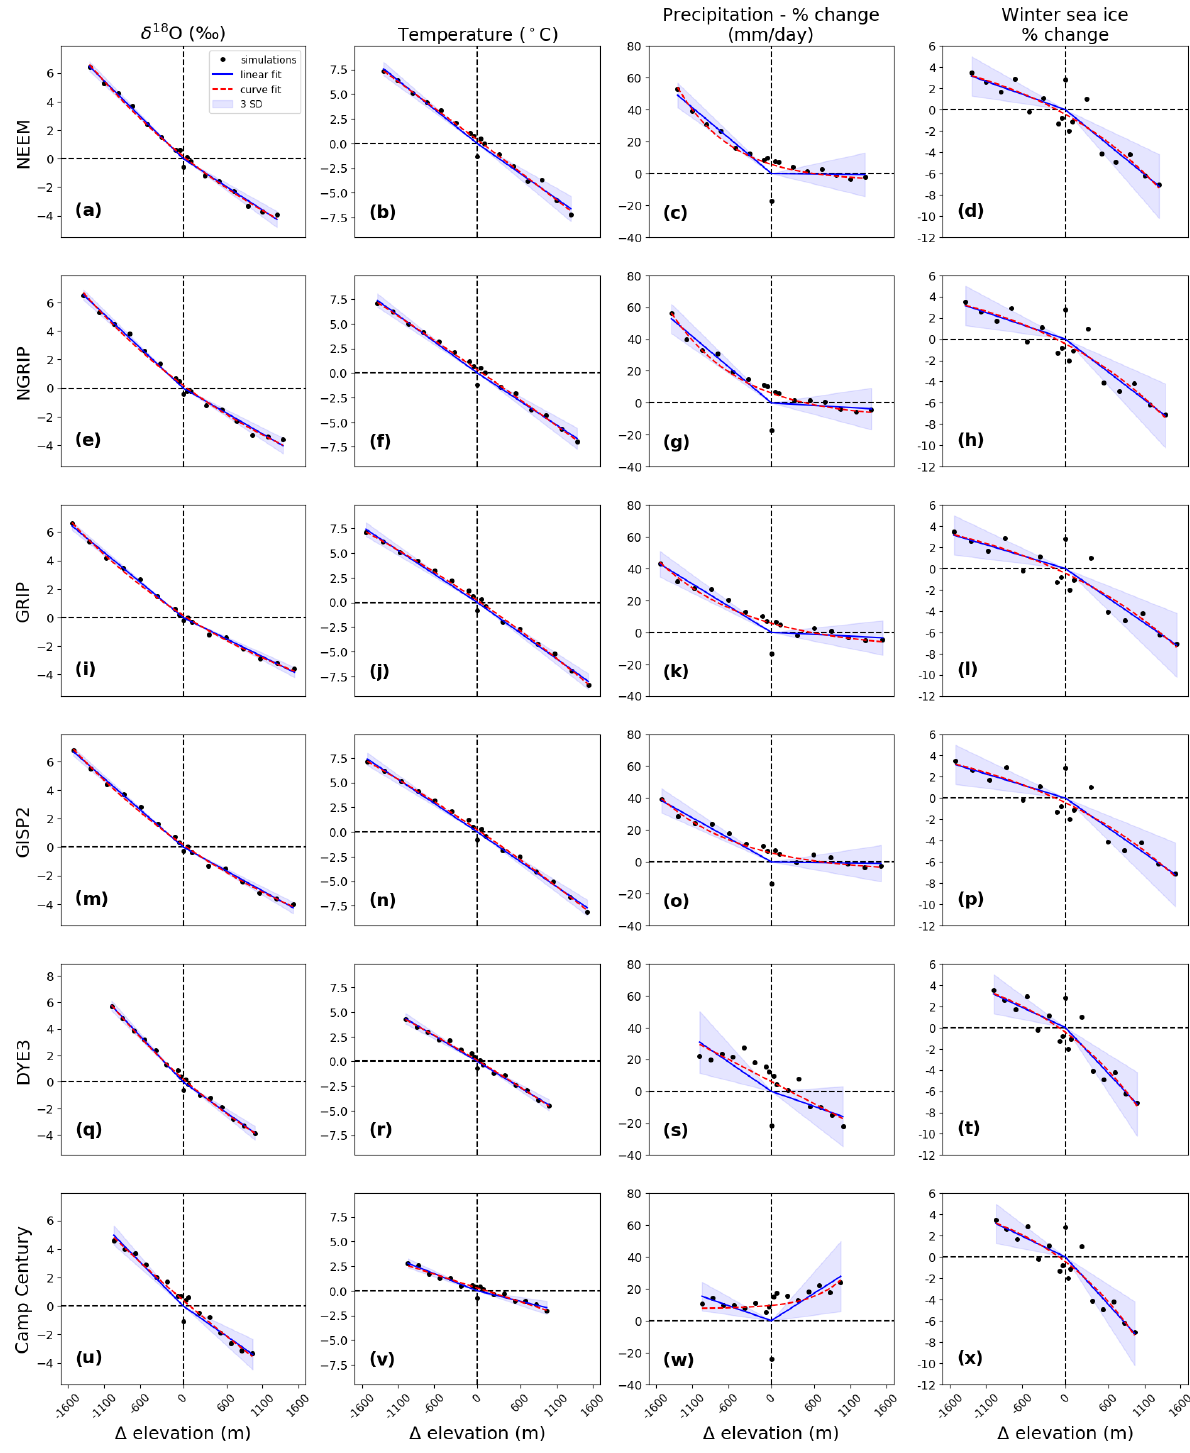
Figure 1. Change in δ 18 O p , temperature, precipitation flux and winter (March) sea ice extent as a function of GIS elevation changes (m). Changes are calculated as anomalies compared to 125ka control experiment. Ice core sites displayed: (a–d) NEEM, (e–h) NGRIP, (i–l) GRIP, (m–p) GISP2, (q–t) DYE3 and (u–x) Camp Century. Results for each of the 16 GIS elevation change scenarios are represented by black dots. Solid blue lines signify best fit lines ( y = ax ). Also shown are ± 3SD (blue-shaded envelopes) on the best fit lines. Additionally, a second fit of the data using an exponential function ( y = ± ae − bx + c ) is included (red lines with dashes). Note that in the last column of plots, winter sea ice extent vs. GIS elevation change differs for the various ice core sites because of the different elevation changes at each ice core site compared to the 125ka